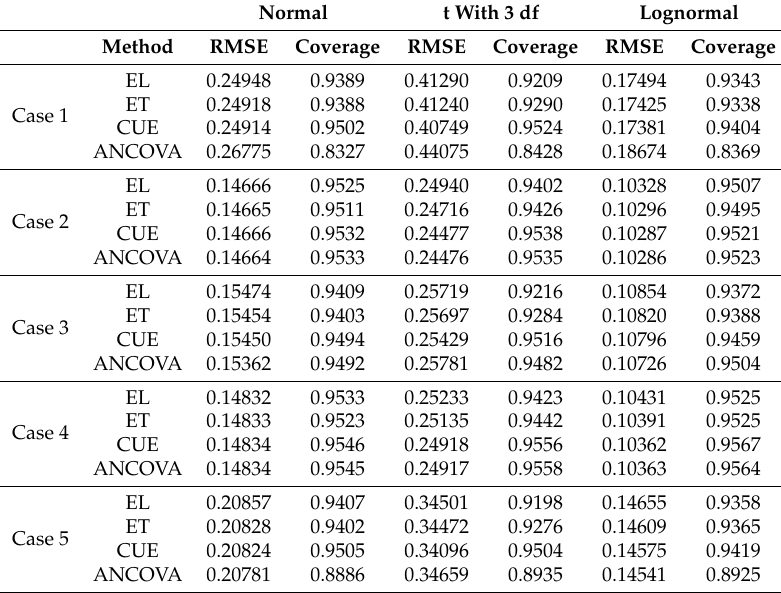
Table 5. Estimated root mean squared error and empirical coverage of nominal 95% confidence intervals (1